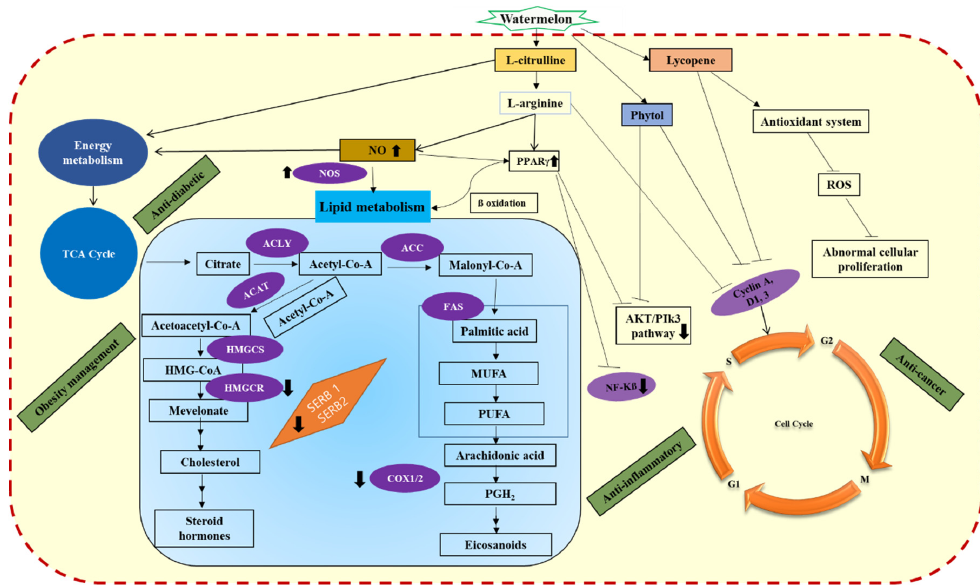
Figure 1. A schematic representation of various mechanisms induced by the phytochemicals present in watermelon extracts. The figure has been conceived based on the interpretation of the literatures